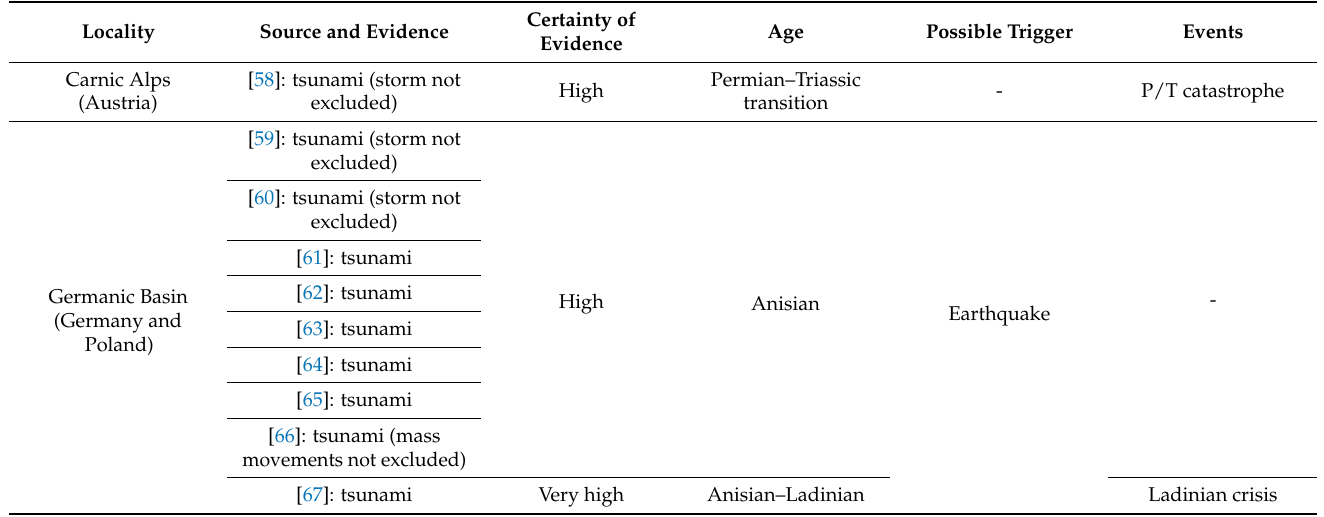
Table 1. The literary evidence for judgments of Triassic